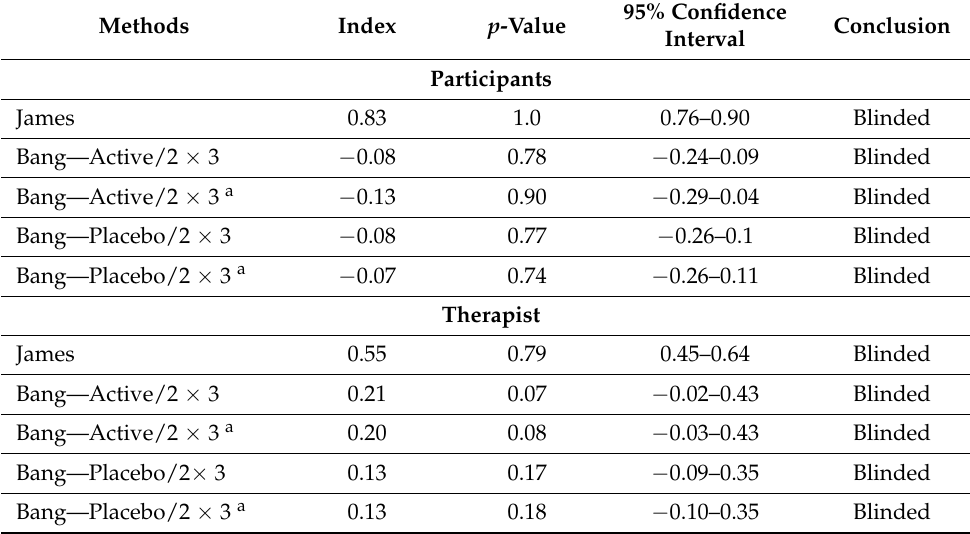
Table 3. Results of participants and therapist blinding. Data analysis of James’ blinding index and Bang’s blinding